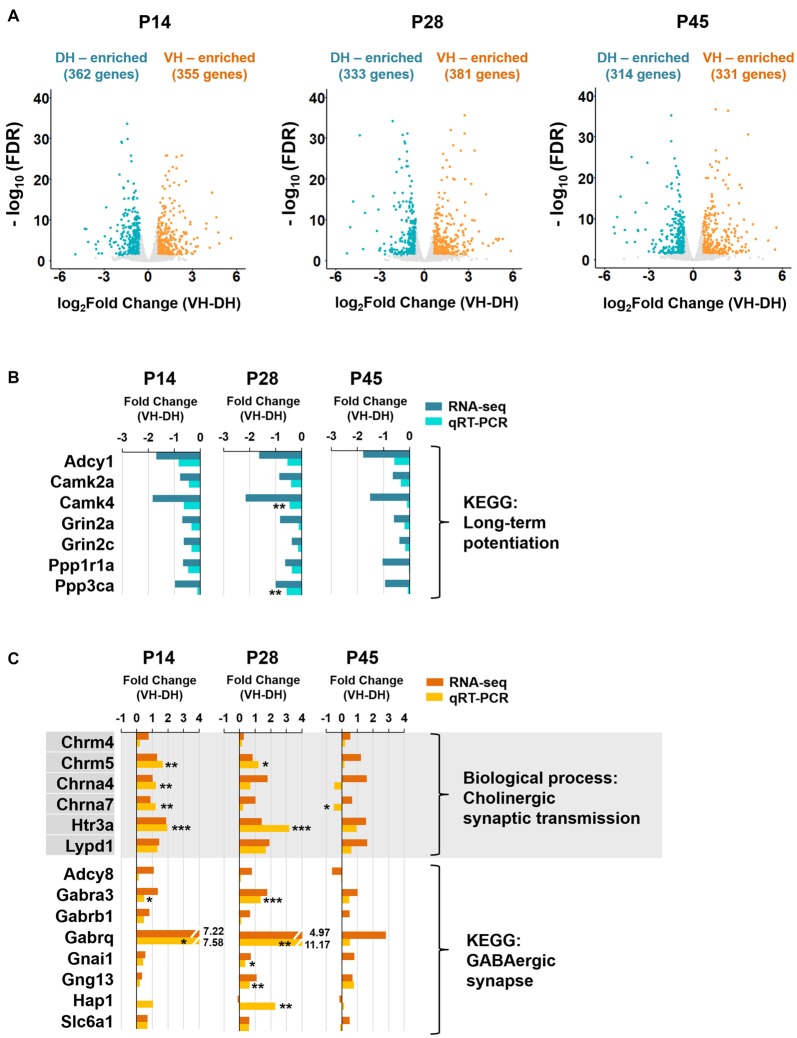
The long-term potentiation pathway is associated with the dorsal hippocampus, whereas cholinergic synaptic transmission and GABAergic synapse are associated with the ventral hippocampus during postnatal development. (A) Volcano plots for the dorsally or ventrally enriched genes in the hippocampus during postnatal development. Genes with a fold change of VH to DH ≥1.5 or ≤−1.5 were defined as ventrally or dorsally enriched genes, respectively, at individual developmental stages (P14, P28 and P45). Refer to Supplementary Table S1 for the full gene list at each age. DH, dorsal hippocampus; VH, ventral hippocampus. (B) qRT-PCR validations of the genes belonging to the long-term potentiation pathway associated with dorsally enriched gene groups at P14, P28 and P45 (Supplementary Figure S3B). RNA-seq and qRT-PCR values of each gene were compared at each developmental ages. n = 3–4 independent samples. **p < 0.005 for VH compared with DH, Student’s t test. Refer to Supplementary Table S5 for detailed statistics, including n number, t-value, degree of freedom and p-value for individual genes. (C) qRT-PCR validations of the genes belonging to the biological process of cholinergic synaptic transmission (Supplementary Figure S4A) and the KEGG pathway of GABAergic synapse (Supplementary Figure S4B) associated with ventrally enriched gene groups at P14, P28 and P45. RNA-seq and qRT-PCR values of each gene were compared at each developmental age, n = 3–5 independent samples *p < 0.05, **p < 0.005, ***p < 0.0005 for VH compared with DH, Student’s t test. Refer to Supplementary Table S5 for detailed statistics, including n number, t-value, degree of freedom and p-value for individual genes.